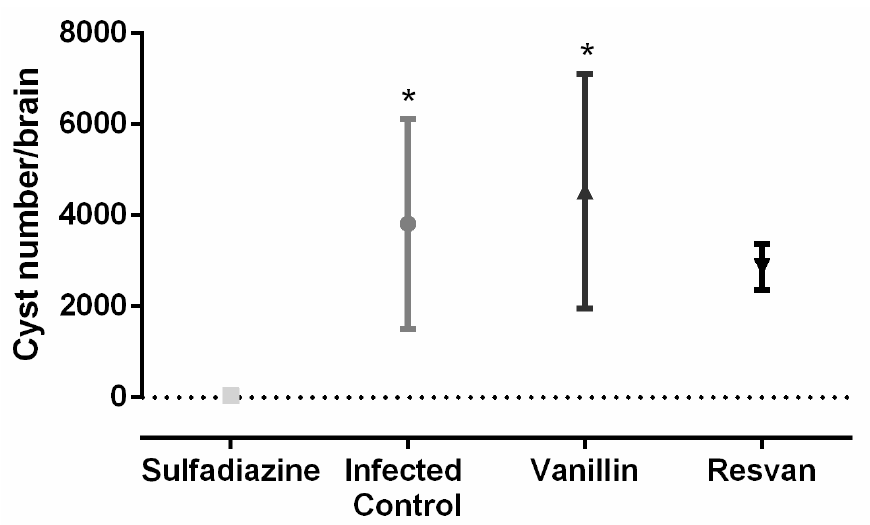
Figure 8. Number of brain cysts in Swiss mice infected with 25 cysts of T. gondii ME49 strain and treated with sulfadiazine (200 mg/Kg), resvan (500 mg/Kg) or vanillin (500 mg/Kg) ( * p < 0.05 compared to sulfadiazine